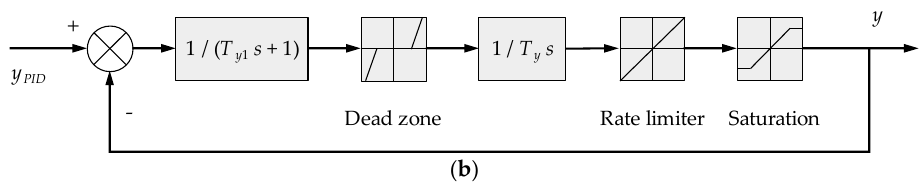
Figure 2. Structure of a hydraulic turbine governor: ( a ) Structure of a parallel proportional integral derivative (PID) controller; ( b ) block diagram of electro–hydraulic servo system.